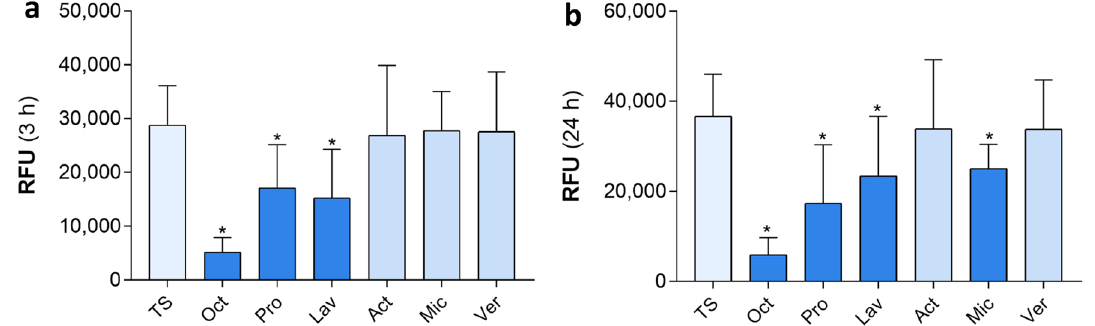
Figure 2. Not all wound gels inactivate MMPs in wounded human ex vivo skin. Shown are activated ( a ) MMP1, MMP2, MMP8, MMP9, MMP12, MMP14 (3 h activation), ( b ) MMP3, MMP10 (24 h activation) concentration levels in culture supernatants of 48 h cultured human tape-stripped (TS) skin biopsies treated with indicated wound gels as well as a TS untreated control. Samples were analysed in duplicates with an MMP activity assay. Relative fluorescence units (RFU) are indicated. Data is presented as a mean ± standard deviation. A Wilcoxon matched-pairs signed rank test was performed with GraphPad Prism 9.3.1. *p ≤ 0.05; n = 6, female donors, location: abdomen, age range: 20–45 years (panel